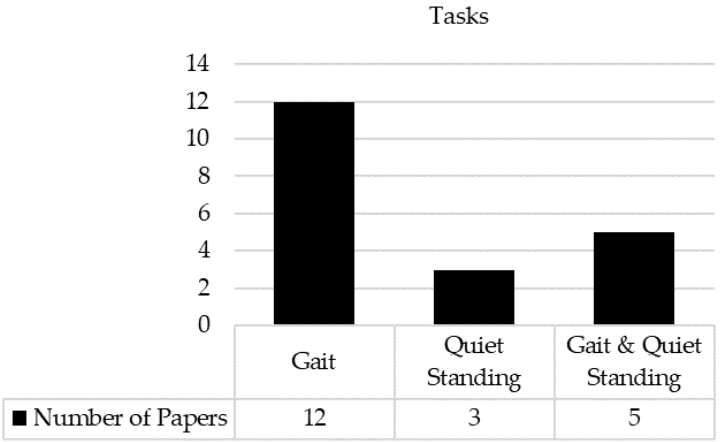
Figure 2. The number of papers for each task.